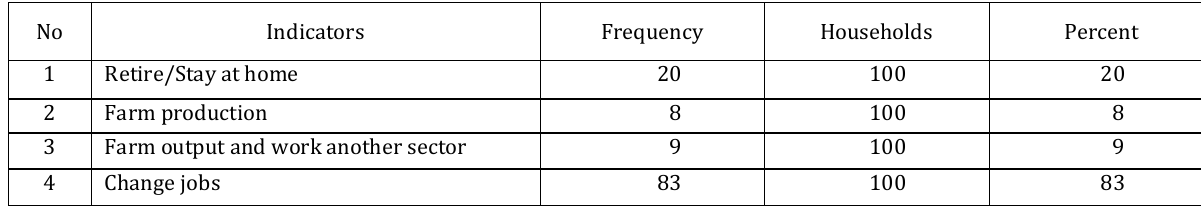
Table 3. Employment status of family members after land acquisition( Source: Households' survey,